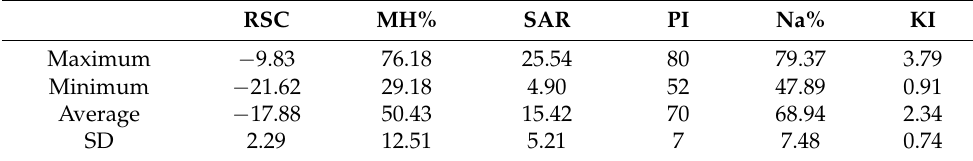
Table 4. Statistical presentation of irrigation indices for groundwater suitability.